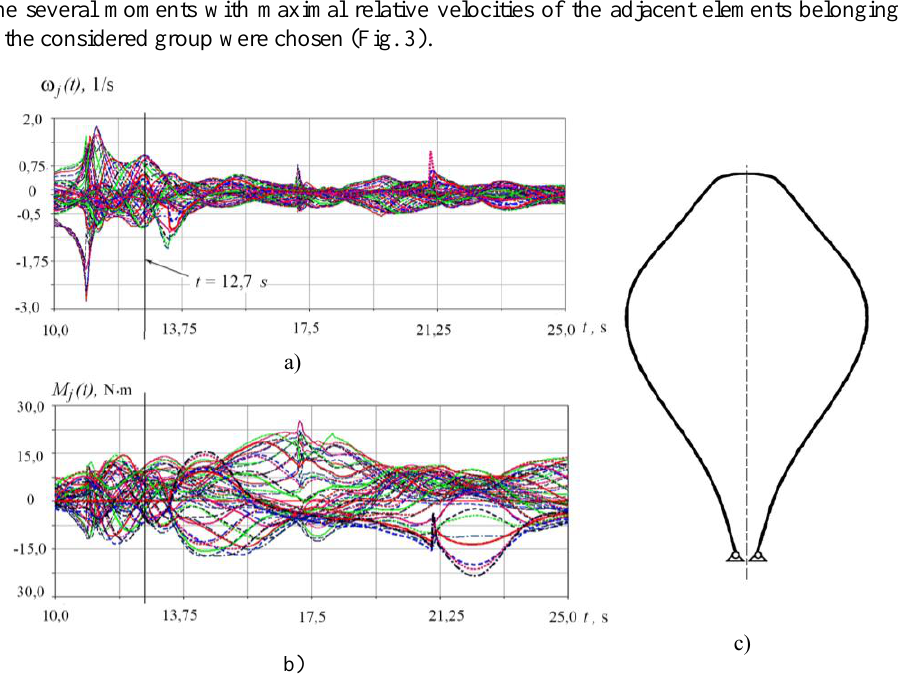
Fig. 3 . Calculation results: а) the angular velocities of the panels belonging to the left branch of the framework; b) moments acting in the hinge joints when the panels are setting at the stops; c) the shape of the unfolded framework at t  12.7